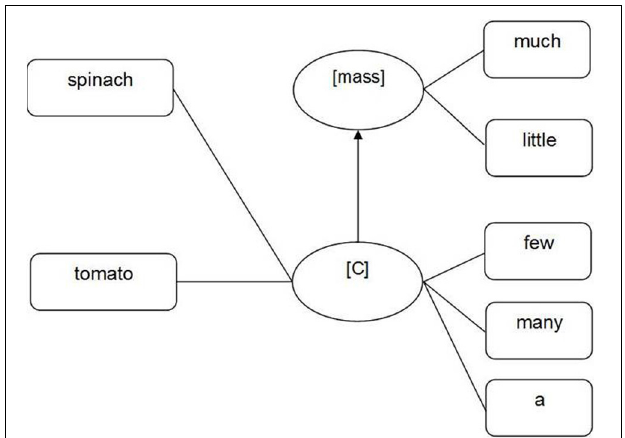
FIGURE 6 | Representation of mass nouns (e.g., spinach) and count nouns (e.g., tomato) at the lexical-syntactic (lemma) level derived from assumptions about the representation of the fixed intrinsic lexical-syntactic property gender in Jescheniak and Levelt (1994) and Levelt et al. (1999).